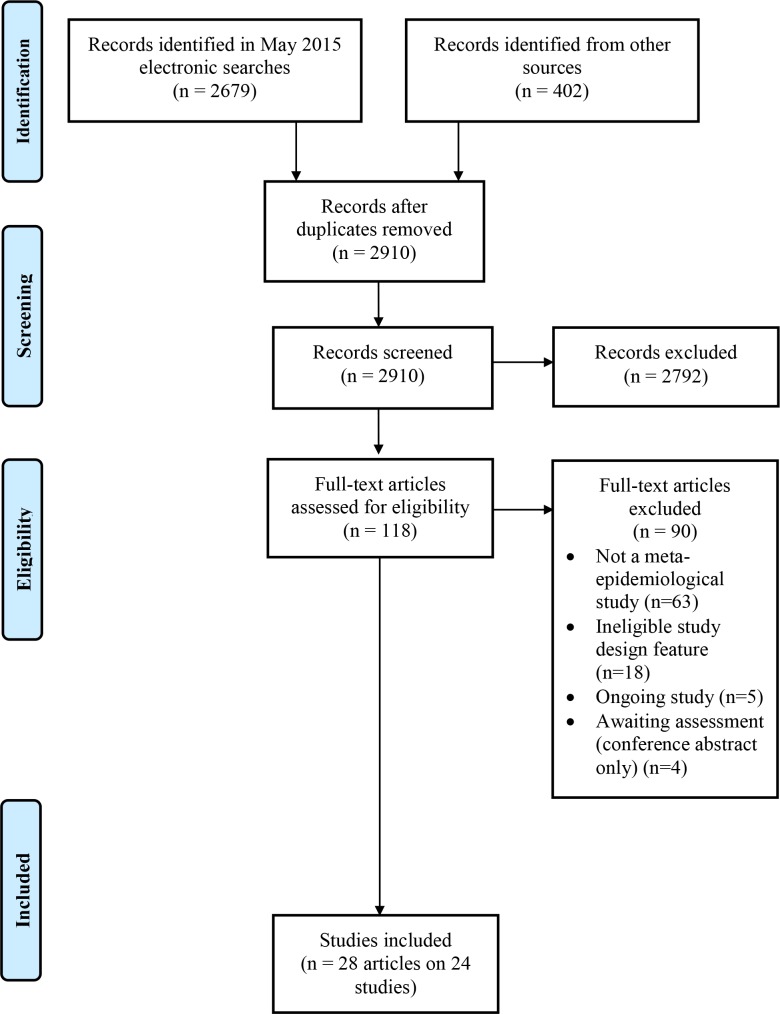
Flow diagram of identification, screening, and inclusion of trials.